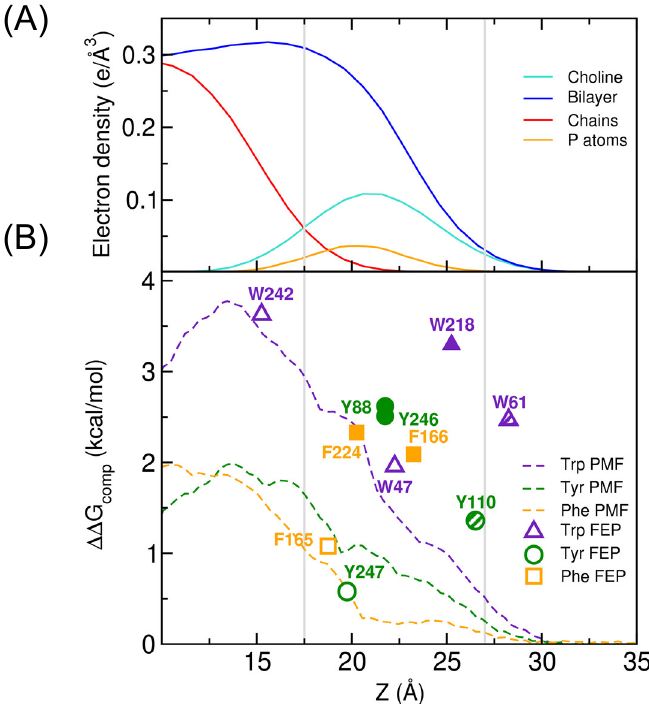
Figure 10. Computed ∆∆ G transfer , which is ∆ G transfer (Aro)– ∆ G transfer (Ala), as a function of insertion depth, Z, the distance to the bilayer center. ( A ) Electron density profiles for different parts of phosphatidylcholine. ( B ) Free energy perturbation values for Trp (triangles), Tyr (circles), and Phe (squares). Filled symbols indicate amino acids with cation- π occupancy above 50%; hashed symbols indicate moderate cation- π occupancy (30–50%); empty symbols indicate occupancy <30%. PMF values are plotted as dashed lines. Reprinted with permission from Waheed et al. (2019) J. Phys. Chem. Lett. 10, 3972–3977. Copyright 2019, American Chemical Society.